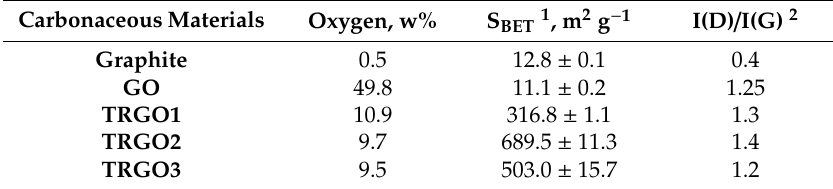
Table 1. Structural characteristics of graphite, graphene oxide, and thermally reduced graphene oxide fractions [23].